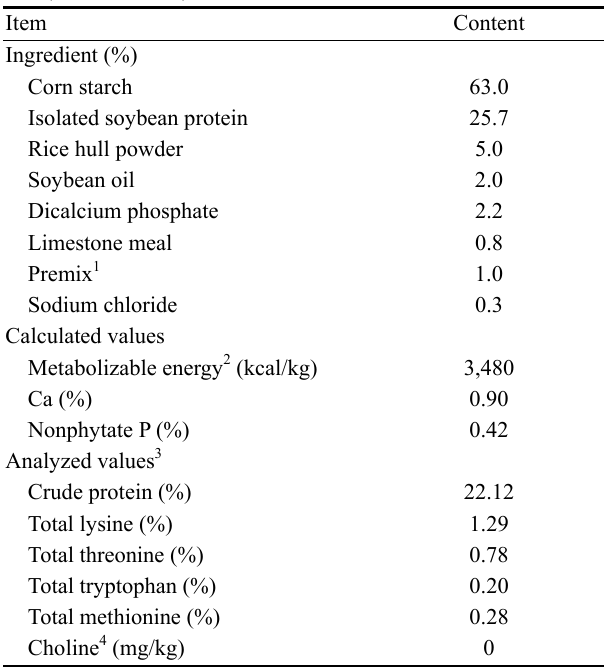
Table 1. Ingredient composition and nutrient content of the